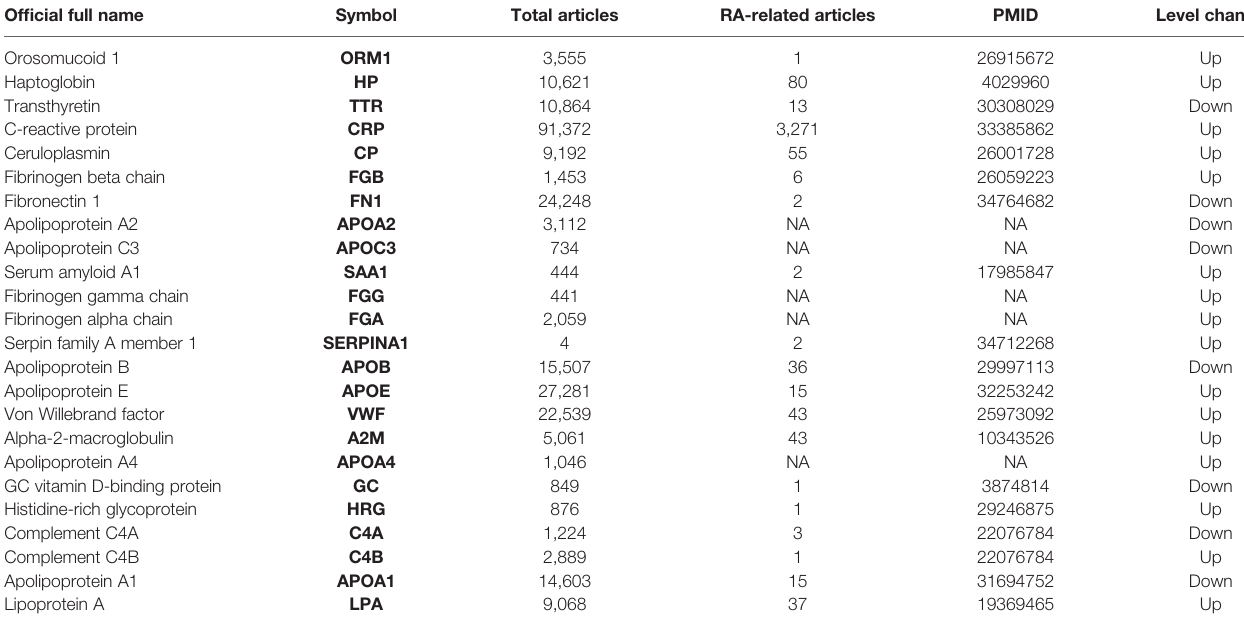
TABLE 3 | Summary of human proteome datasets for biomarker